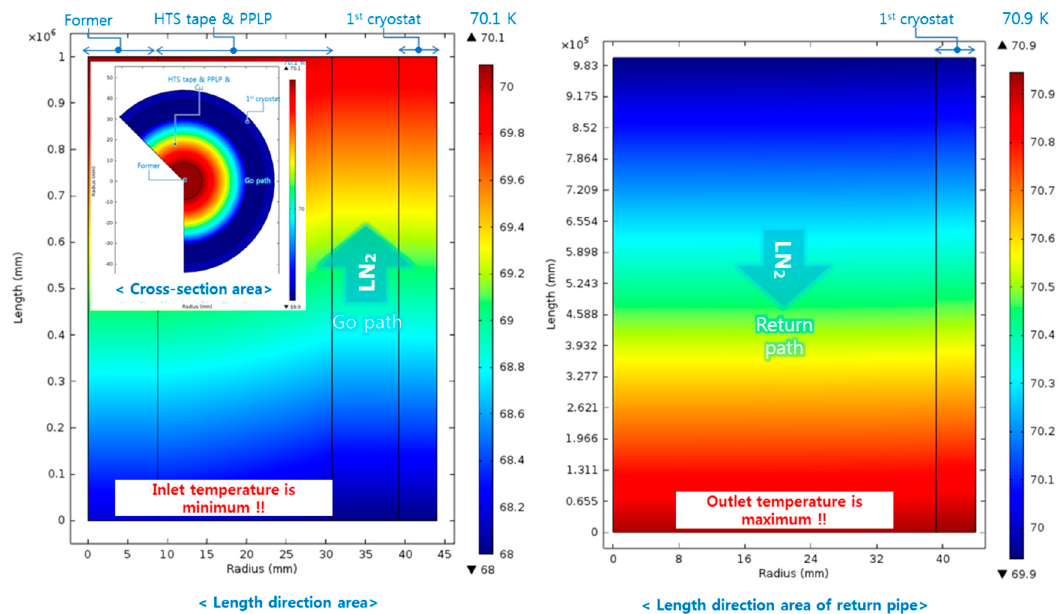
Figure 7. Temperature analysis results of length direction and the cross section of Case III (1 km).